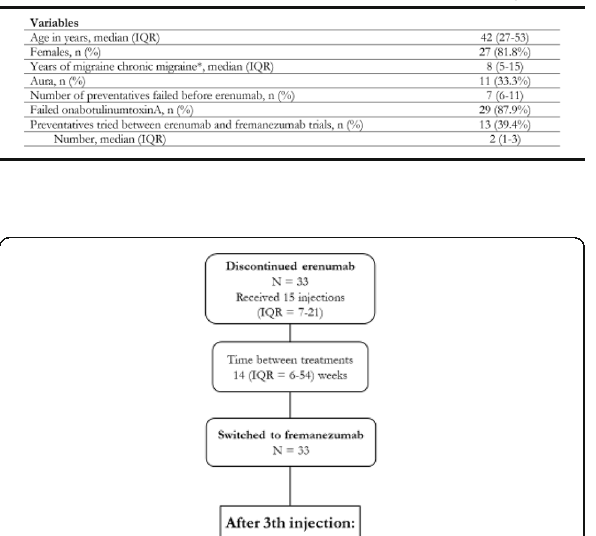
Table 1 (abstract A257). Sample characteristics (n=33). *missing data